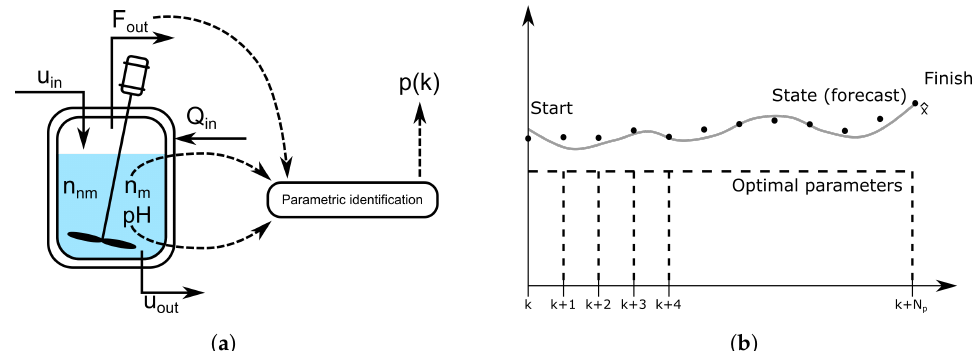
Figure 3. Optimal-based schematics procedures. ( a ) identification parametric diagram; ( b ) identifica- tion parametric